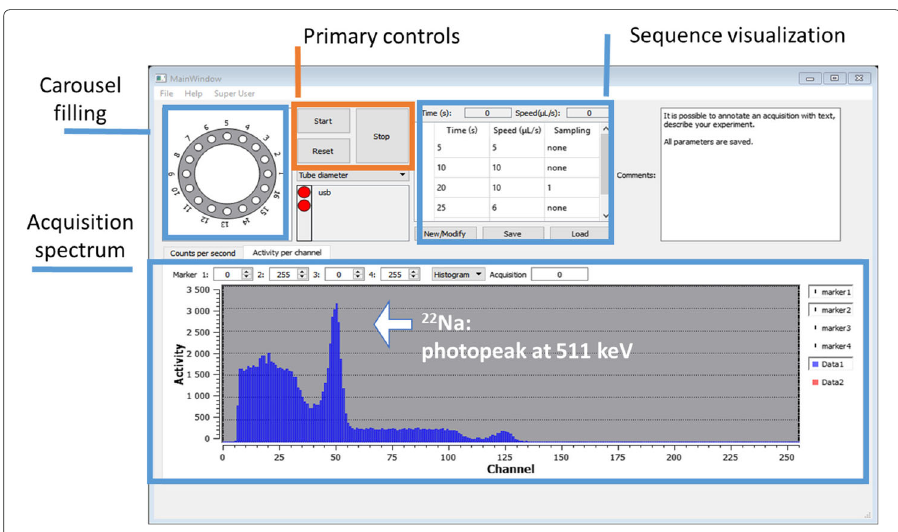
Fig. 5 Screenshot of the GUI, showing the various controls and visualisation elements and a typical 22 Na